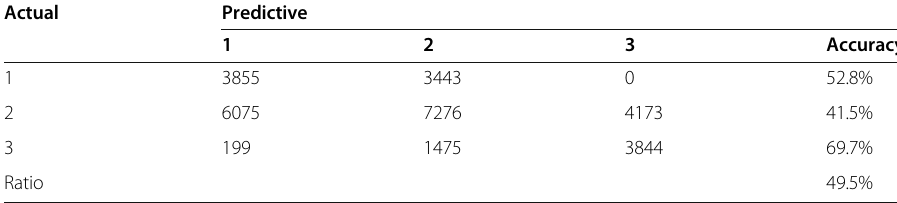
Table 3 Discriminant analysis of naive Bayes classification algorithm